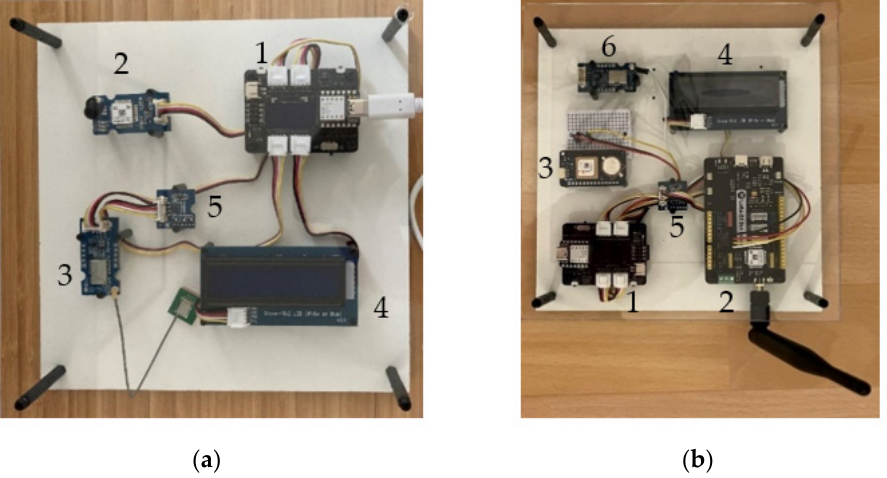
Figure 1. Built microcontroller modules: ( a ) Module A, initial; ( b ) Module B, improved. (1): Micro- controller incl. expansion board; (2): LoRaWAN module; (3): GNSS-Sensor incl. patch antenna; (4): LC-Display; (5): Accelerometer; (6—improved module only): Fallback GNSS-Sensor.